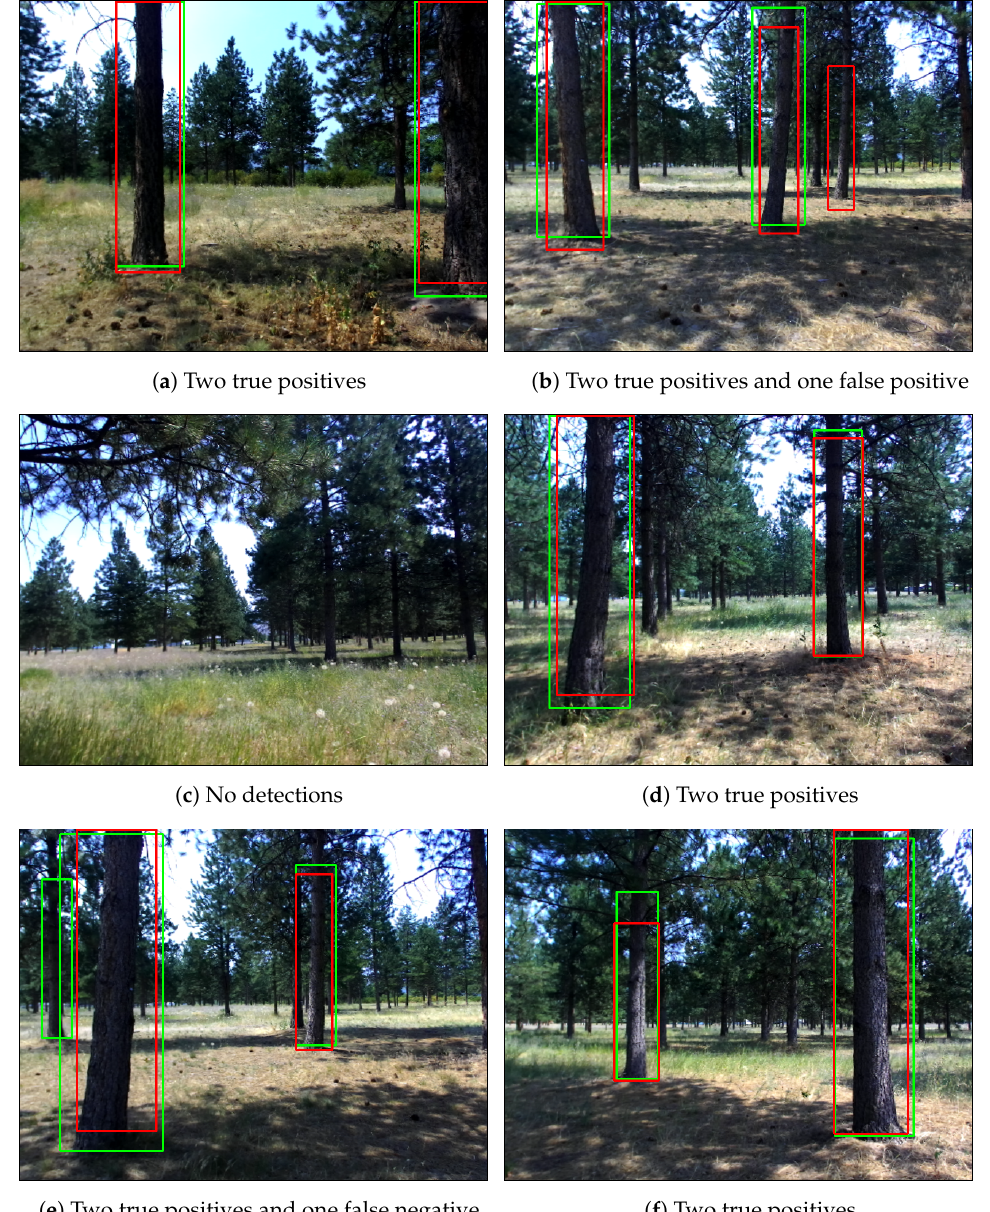
Figure 3. Example detections with ground truth boxes in green and predicted boxed in